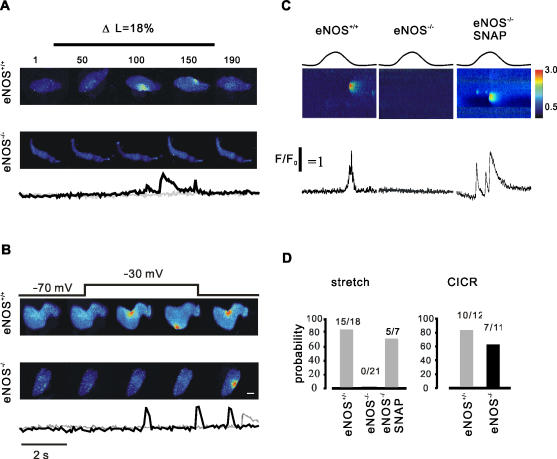
eNOS gene deletion alters the property of stretch- induced Ca2+ sparks in smooth myocytes.A, representative x-y images recorded from a wildtype (upper) and an eNOS deficient smooth myocyte (lower). The stretch-dependence of Ca2+-spark frequency is present in fluo-4-loaded smooth myocytes from the wild type (WT, 15 out of 18 experiments) but absent in those from eNOS-deficient mice (0 out of 21 experiments); the below of the images are profiles of Ca2+ ratio from WT (black) and eNOS null (gray) cells. B, sample of x-y images recorded from membrane voltage depolarized WT (upper) and eNOS knockout (lower) smooth myocytes; compared to WT cells, the eNOS deletion cells have a low Ca2+ spark probability (see also D, right). C, linescan images recorded from WT (left), eNOS null cells (middle) as well as in the presence of SNAP (right). D, summary data of Ca2+ spark probability in WT and eNOS deficient smooth myocytes.